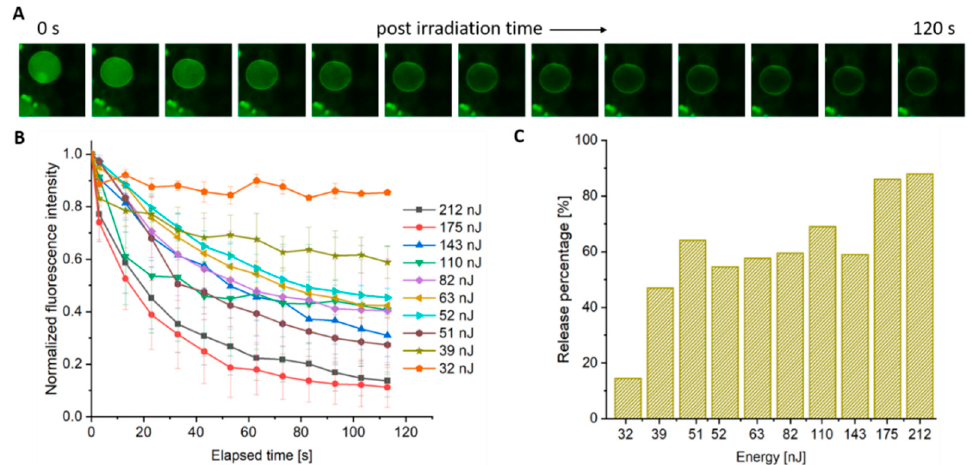
Figure 5. Encapsulant release as a function of time from Polymersomes loaded with 0.04% ( w / v ) AuNPs. ( A ) A sample time series displaying a decrease in fluorescence intensity as a function of time as FITC-dextran di ff uses out of the vesicle after the delivery of a single 212 nJ pulse. ( B ) The fluorescence intensity inside of an individual vesicle is measured as a function of time following a single 532 nm, fs pulse at the indicated energy. Each line represents the fluorescence decay in a region of interest (ROI) (3–4 replicates +/ − standard error of the mean (SEM)). ( C ) Total encapsulant release after 120 s at the indicated pulse